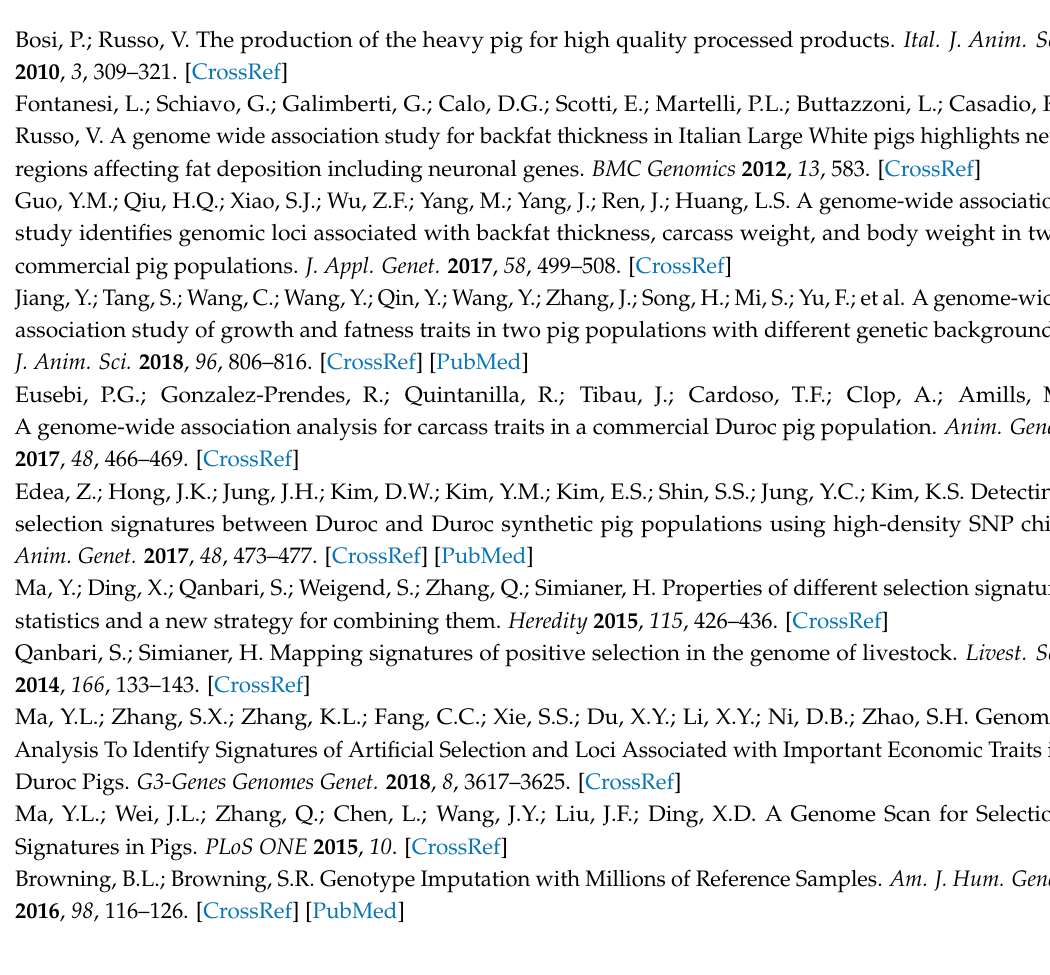
Table S1: the correlation coefficients and the other descriptive statistics of six backfat thickness traits. Table S2: a list of candidate regions revealed by iHS method. Table S3: summary and annotation of the SNPs associated with backfat thickness in Yorkshire pigs. Table S4: the summary of selection signatures for six backfat thickness traits. Table S5: the results of GO analysis and pathway analysis. Table S6: QTLs overlapped with the trait-specific selection signatures identified by F ST and XPEHH simultaneously. Table S7: the summary of XPEHH scores for trait-specific selection signatures. Figure S1: The violin plot of expected heterozygosity in each subpopulation for backfat thickness traits. Figure S2: Visualization of trait-specific selection signatures for backfat between 6th and 7th thoracic vertebras (BF2). Figure S3: Visualization of trait-specific selection signatures for backfat at 10th rib (BF3). Figure S4: Visualization of trait-specific selection signatures for backfat at thoracolumbar junction (BF4). Figure S5: Visualization of trait-specific selection signatures for backfat at waist recommended vertebral junction (BF5). Figure S6: Visualization of trait-specific selection signatures for the average backfat thickness of three points